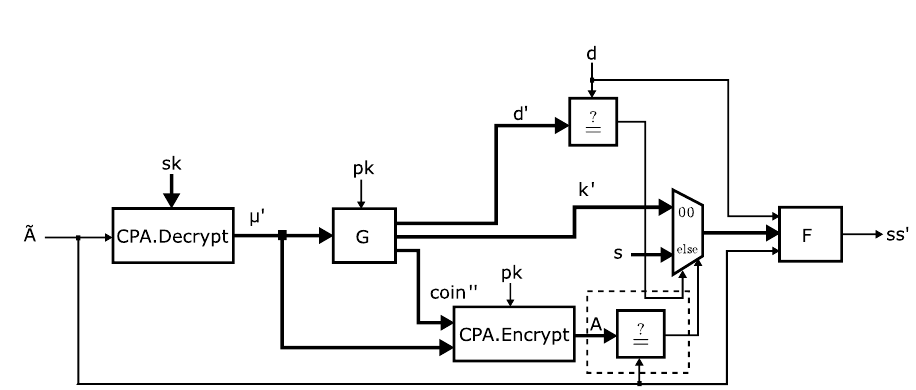
Figure 1: IND-CCA-secure variant of the NewHope KEM. The dashed line highlights the comparison component that is subject of this work. Bold lines indicate masked